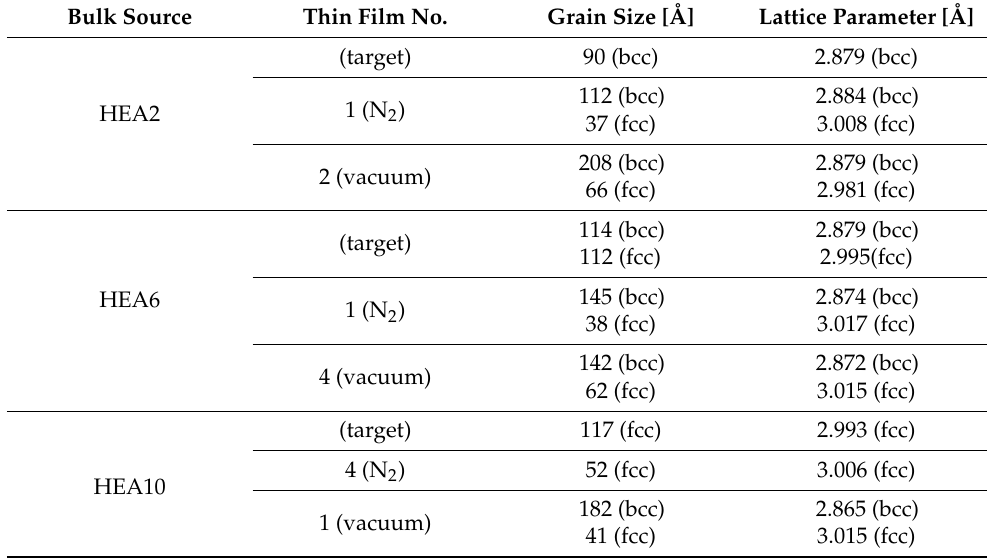
Table 2. Summary of physical parameter values determined for indicated thin films.